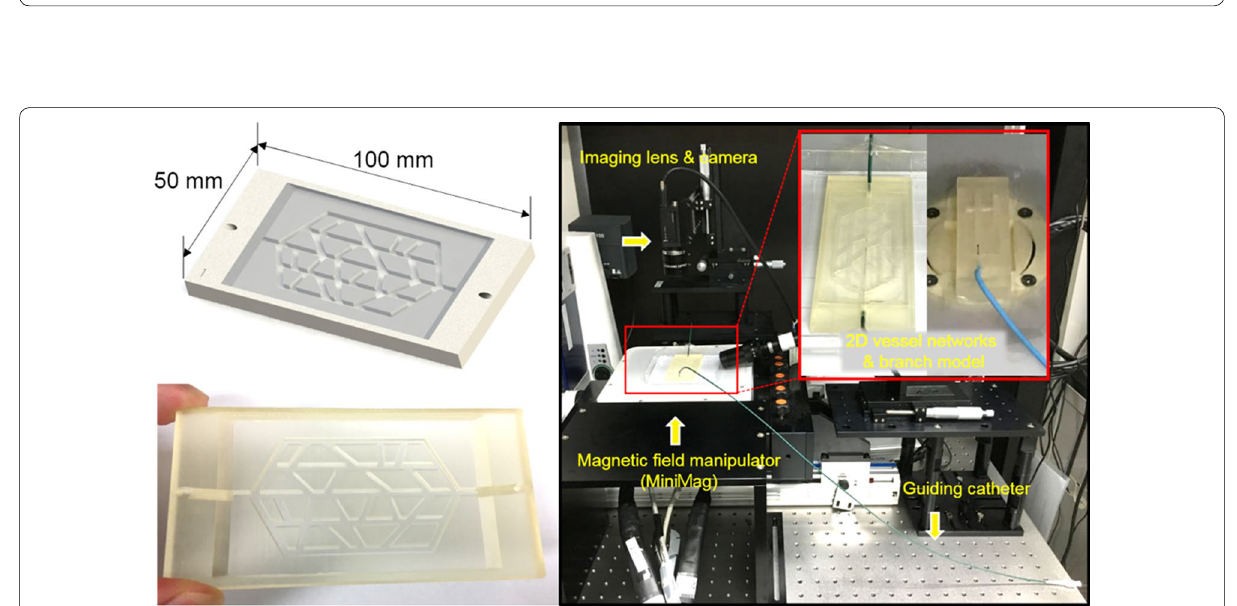
Fig. 8 Tracking of the guidewire‑based flexible microrobot in a two‑dimensional blood vessel phantom with branches at various